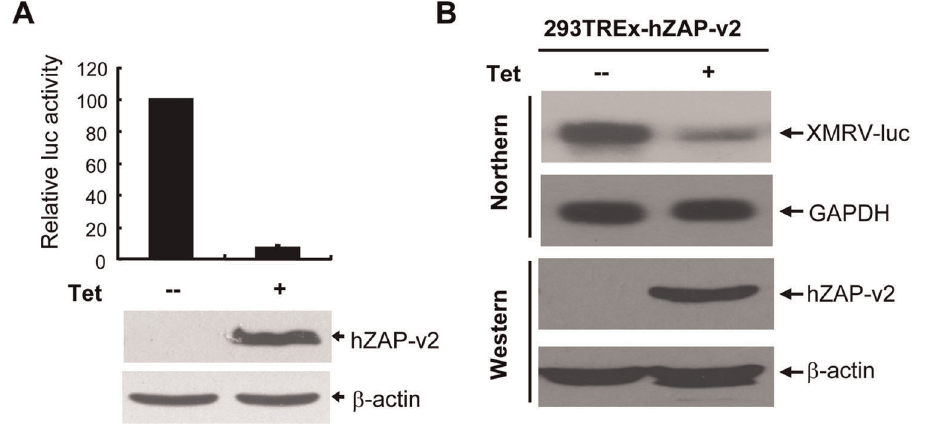
Figure 3. Expression of hZAP prevents the accumulation of XMRV-luc mRNA. 293TRex-hZAP-v2 cells harbouring XMRV-luc provirus were mock treated or treated with 1 m g/ml tetracycline for 48 h to induce ZAP expression. (A) Cells were lysed and luciferase activity was measured (upper panel). Data presented are means 6 SD of three independent experiments. The expression of hZAP was confirmed by Western blotting (lower panel). (B) Cytoplasmic RNA was extracted and subjected to Northern blotting to detect the mRNA indicated (upper panel). Expression of hZAP was confirmed by Western blotting (lower panel).